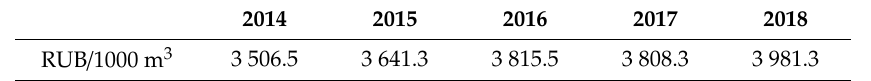
Table 4. Average gas price in Russia (net of VAT, excise tax, and customs duties) (data from [50]).